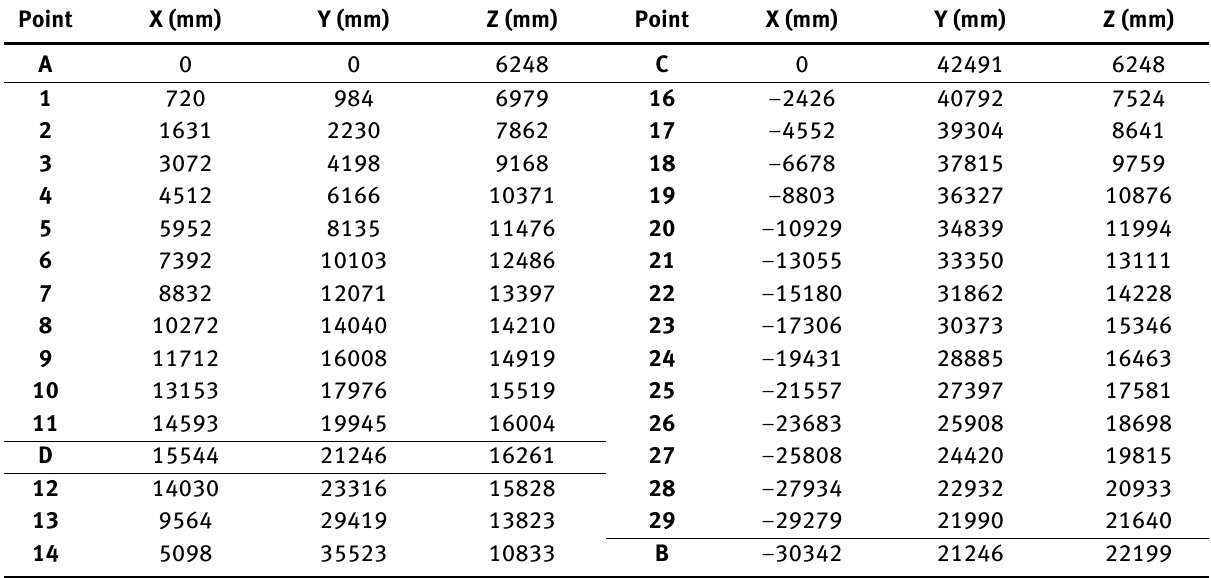
Table 1: Coordinates of shell